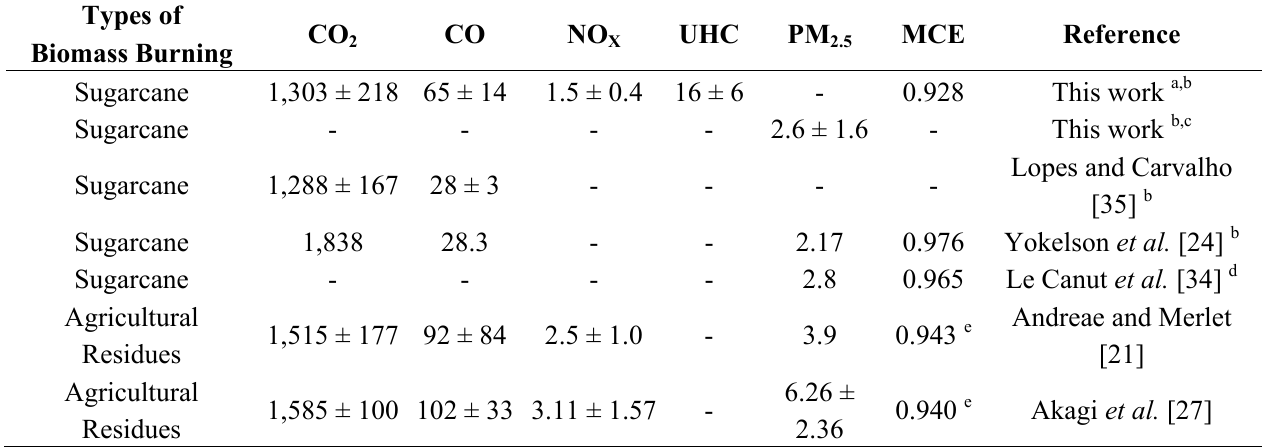
Table 1. Emission factors (g kg − 1 of dry burned biomass) and